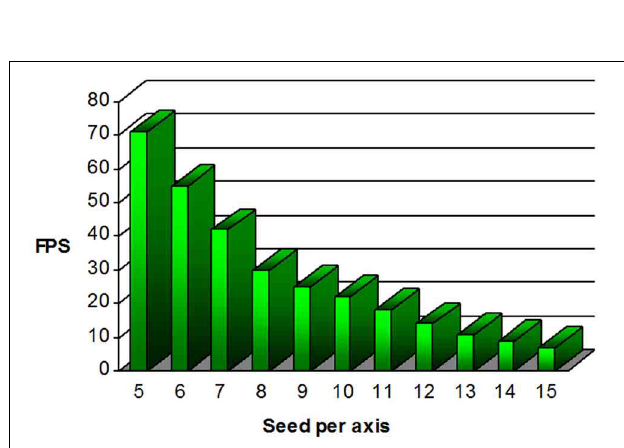
(C) one can observe a premature termination of the fiber tracts inside the tumor (red lines). By lowering the FA threshold to 0.06, we allow the tracts to momentarily step over small local changes in the diffusivity and continue their course toward the cortex (D) . (TP dataset).